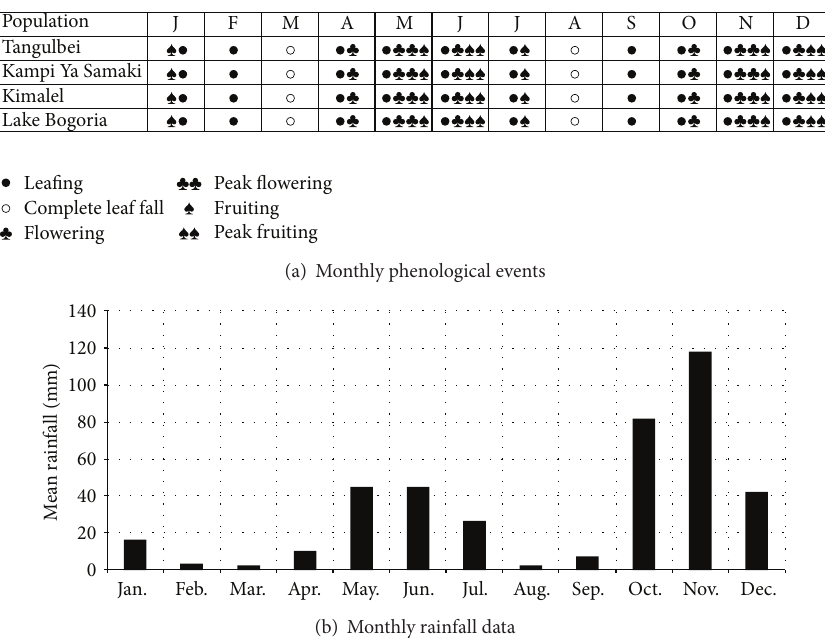
Figure 3: (a) Monthly leafing, flowering, and fruiting events of S. senegal and (b) mean monthly rainfall amounts in Lake Baringo woodland ecosystem.